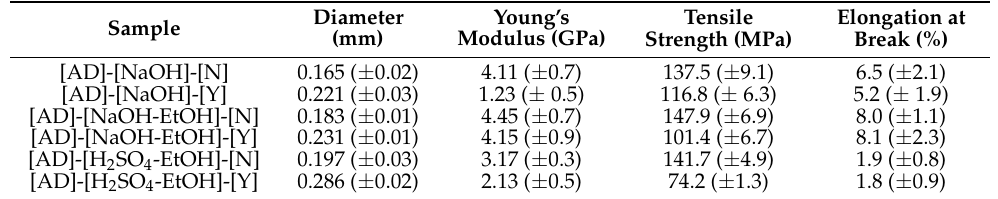
Table 3. Mechanical properties of wet spun monofilaments using adipic acid as the solvent.